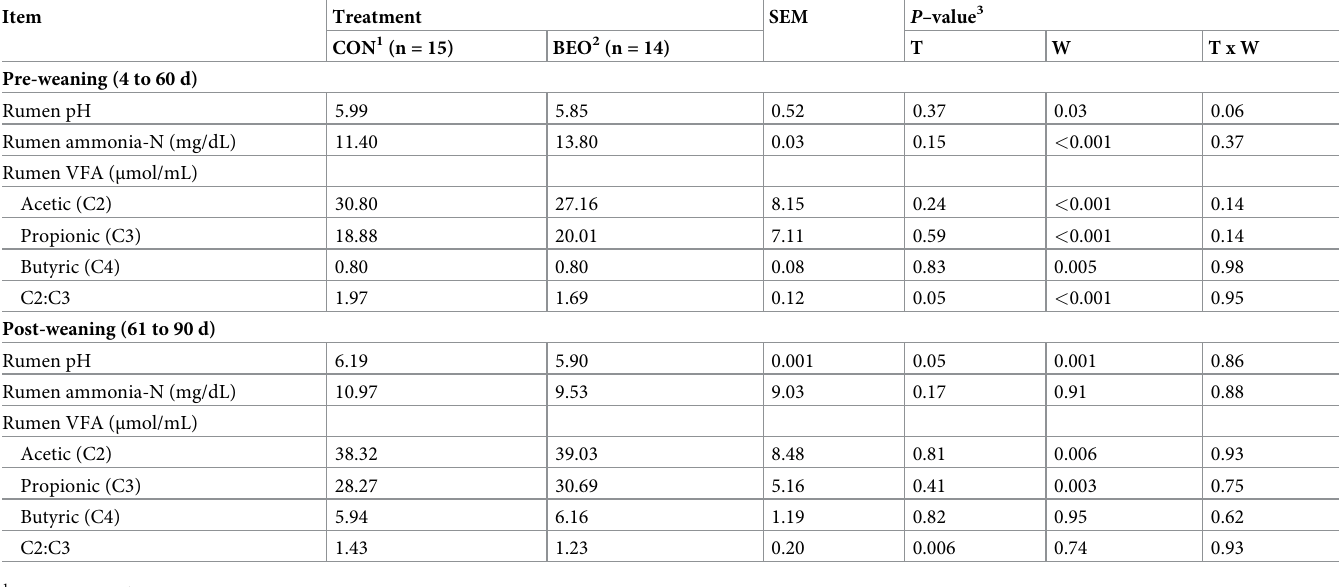
Table 4. Pre- and post-weaning rumen mean values of rumen pH, ammonia nitrogen (Ammonia-N) and volatile fatty acids (VFA) of control heifers (CON) and heifers supplemented with essential oils blend (BEO) in milk replacer during pre-weaning. Item